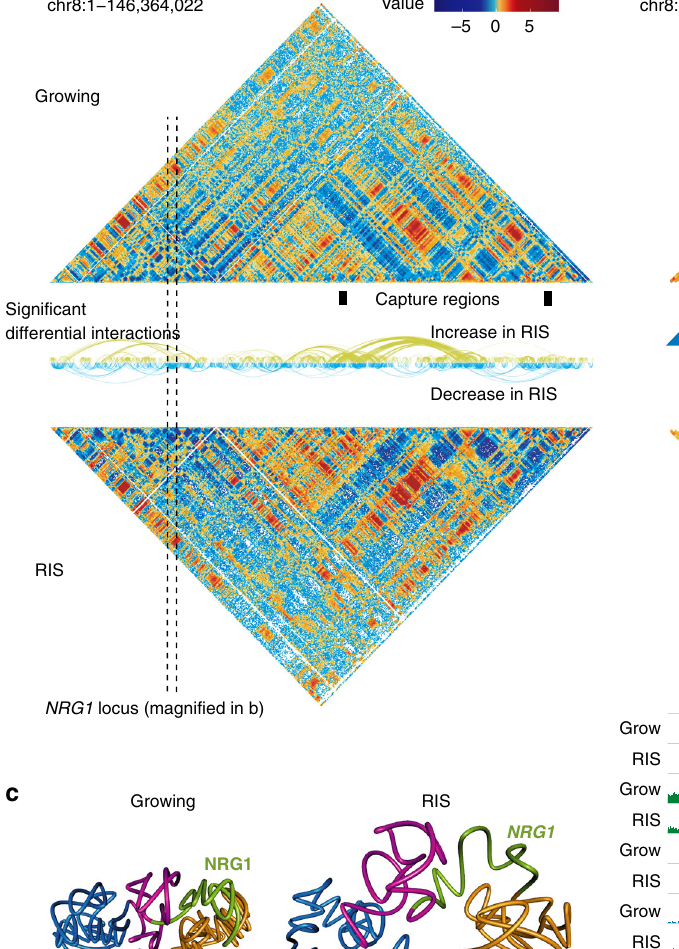
exhibiting nearly overlapping FISH signals in growing cells, but was signi fi cantly longer in RIS cells (Fig. 1d, e and Supplementary Fig. 2d). Note, in RIS cells, gene probes often showed a decondensed form, while TAD probes remained condensed (Fig. 1d and Supplementary Fig. 2d). These data suggest that H3K27me3 regions might contribute to long-range silencing of neighbouring genes through 3D positioning within TADs. This is consistent with a previous study, showing a similar distant